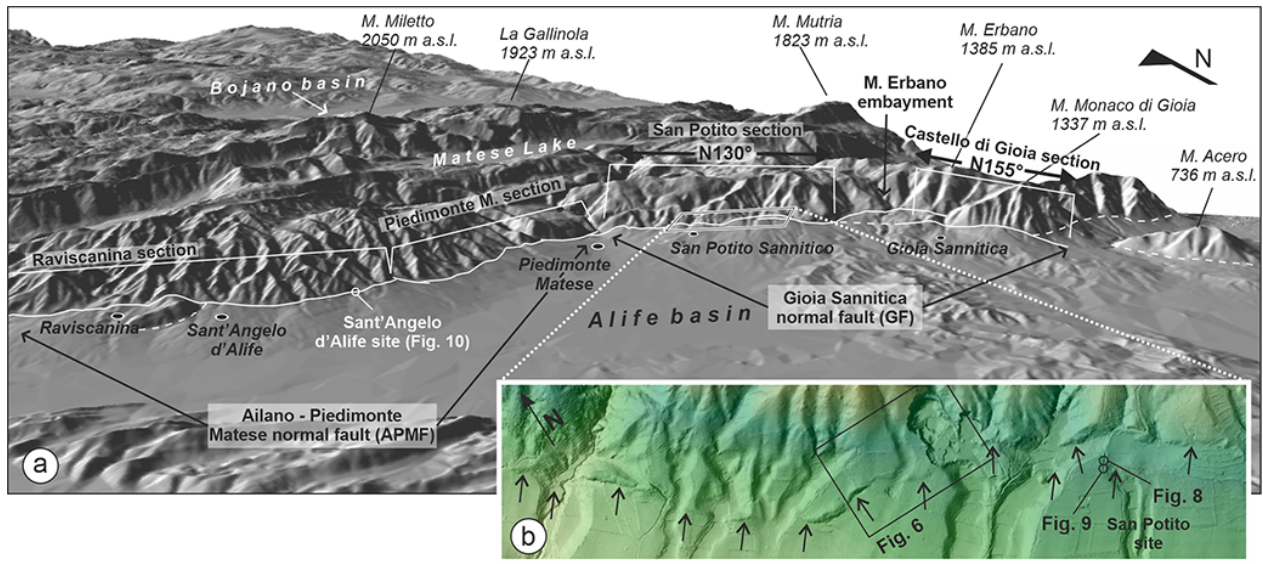
Figure 2. (a) Oblique view of the southern Matese mountain front from a 5m resolution digital elevation model (DEM) with traces of the Ailano–Piedimonte Matese (APMF) and Gioia Sannitica (GF) normal faults. (b) Detailed view of the GF fault trace, indicated by black arrows, on a 1m resolution DEM from airborne